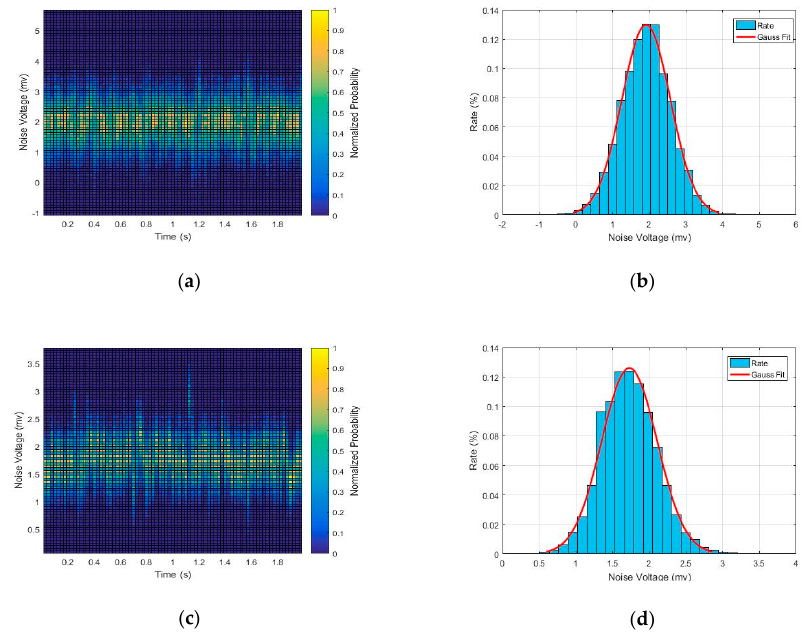
Figure 10. The readout noise of the electronic system: ( a ) the distribution of noise density without the system noise reduction technique; ( b ) the noise histogram and its Gaussian fit for (a); ( c ) the distribution of noise density after the system noise reduction; ( d ) the noise histogram and its Gaussian fit for (c).